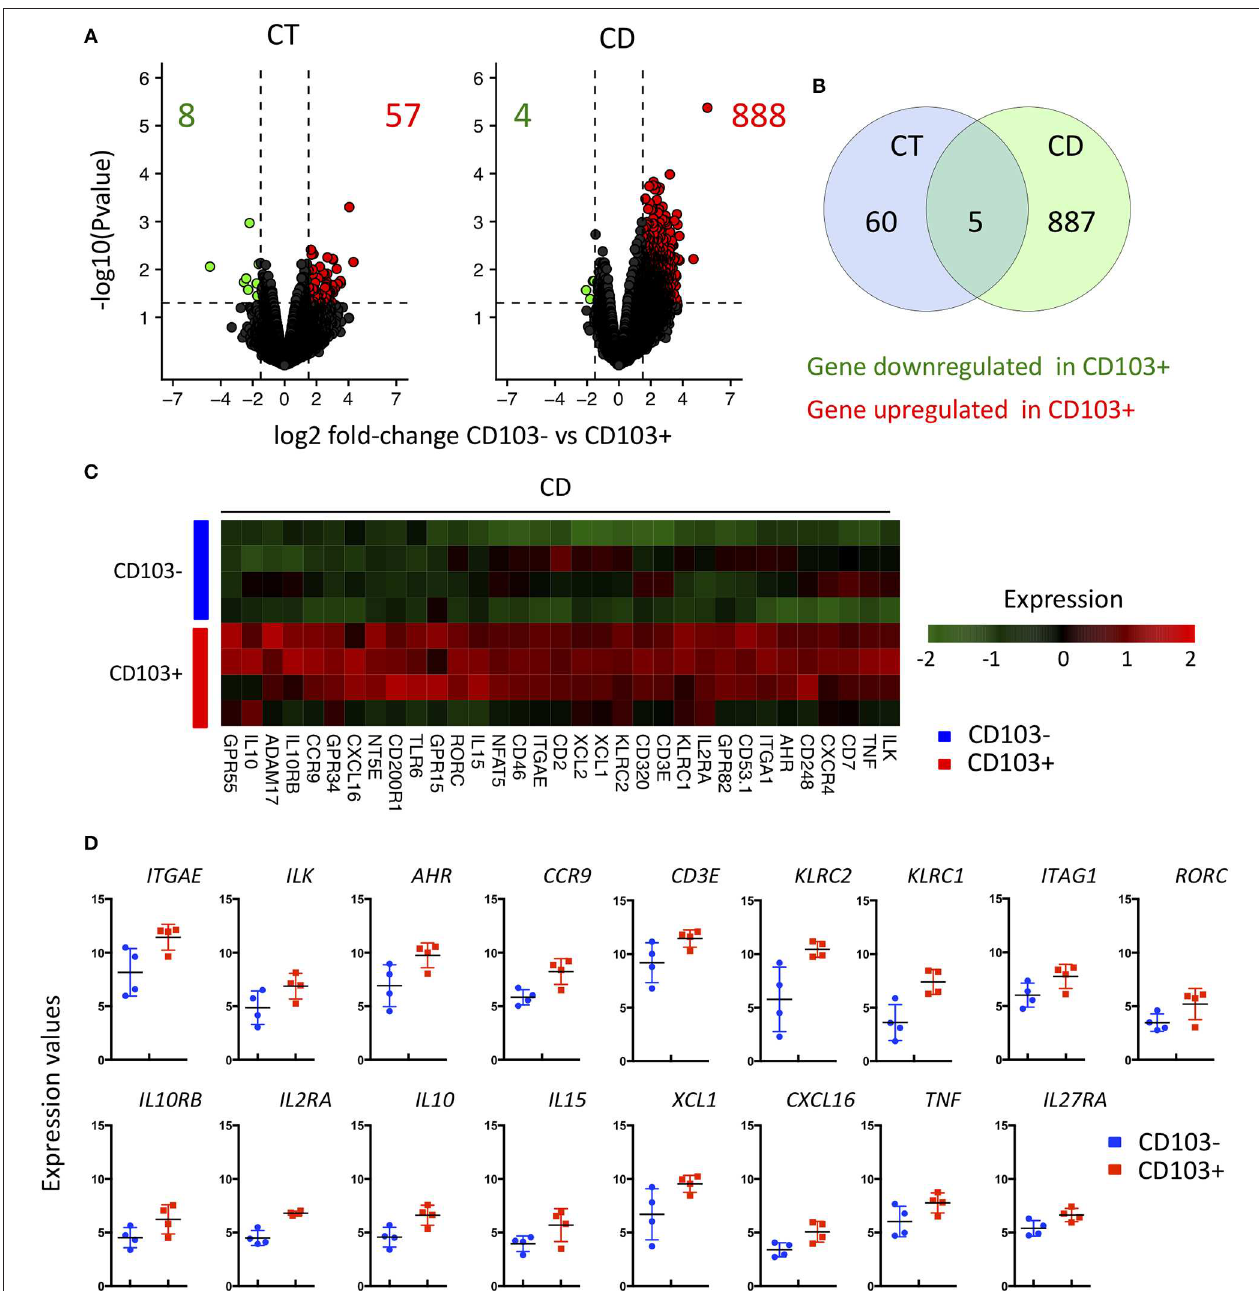
FIGURE 7 | Major transcriptional change between CD103- and CD103 + CD8 Trm cells from CD patient. (A) volcanoplot showing differential expression (fold change > 1.5 and P < 0.05) between CD103- and CD103 + T cells subsets from control tissue (CT; n = 3) and CD patients (CD; n = 4) as indicated. (B) Venn diagram showing number of gene differentially expressed between CD103- and CD103 + T cells subsets of CT and CD patients and overlapped gene. (C) Heatmap of genes differentially expressed (fold change > 1.5 and P < 0.05) between CD103- and CD103 + mucosal T cells from CD patients. (D) Quantification and distribution of expression value of genes of interest (dots and bars represent 4 independent experiments with mean and